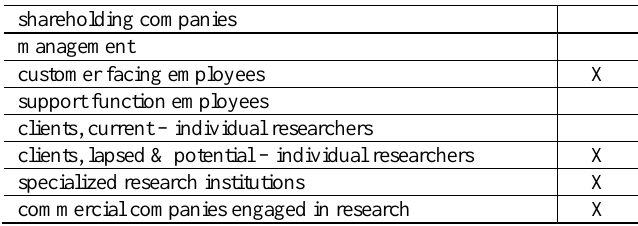
Table 5: Participants loading on Factor